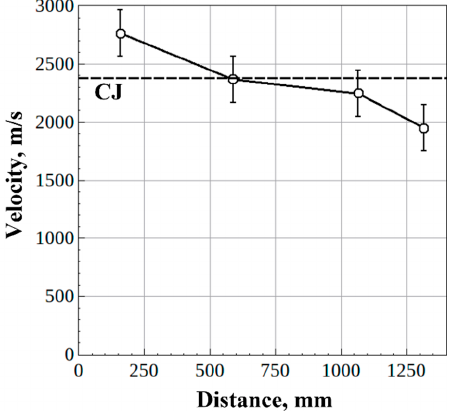
Figure 6. Mean detonation velocity at the various measuring segments of the pulsed detonation gun in several operation cycles.